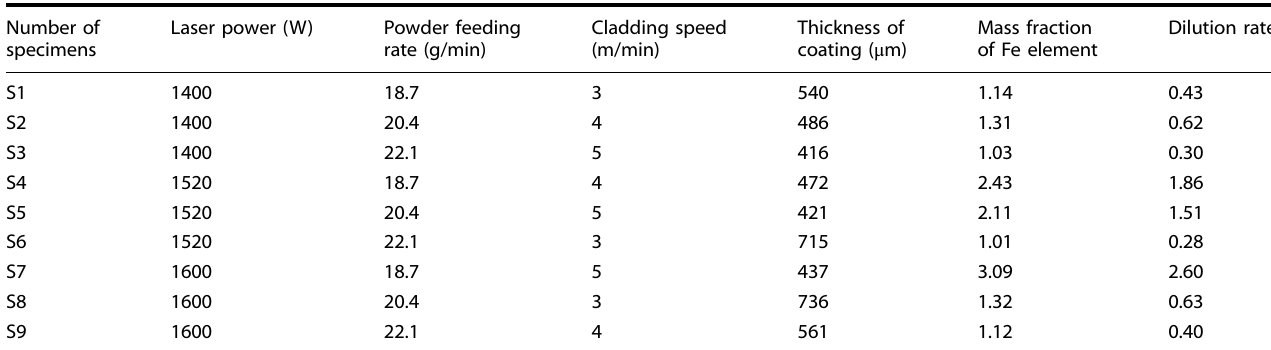
Fig. 6 An examination of the hardness and wear resistance of specimens. a Cross-section hardness of Inconel 625 coatings on Q245R steel: (S4, green), (S5, red), (S6, blue), respectively; b the friction coef fi cient curves of substrate: Q245R steel (black), and Inconel 625 coatings on Q245R steel: (S4, green), (S5, red), (S6, blue), Table 2. Multiple variations in processing parameters of Inconel 625 coatings.